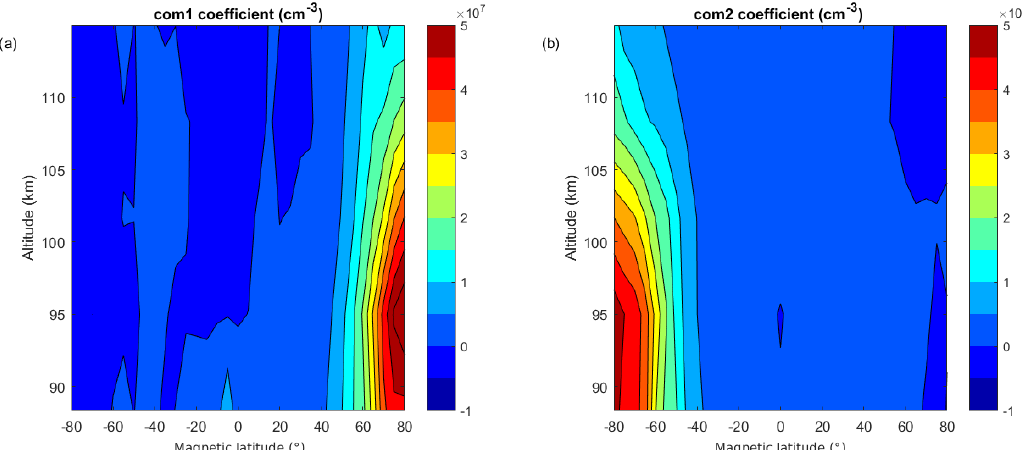
Figure 9. The coefficients corresponding to the (a) com1 and (b) com2 indices.